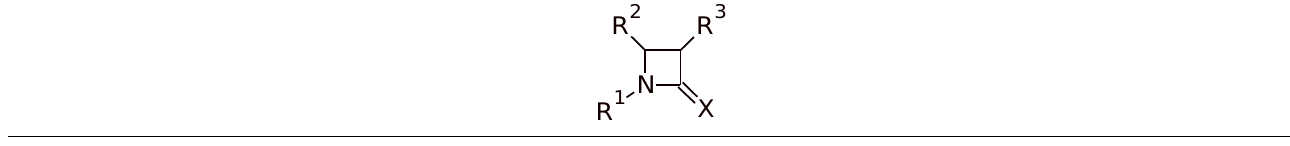
Table 2. Comparison of the Main Stereoelectronic Features of the Azetidine Rings in Penicillin G and 2-Nitroazetidine 22 as Obtained through Quantum-Mechanical Calculations (DFT ῶ B97X-D/6-31G*//DFT ῶ B97X-D/6-31G*, Gaseous Phase).